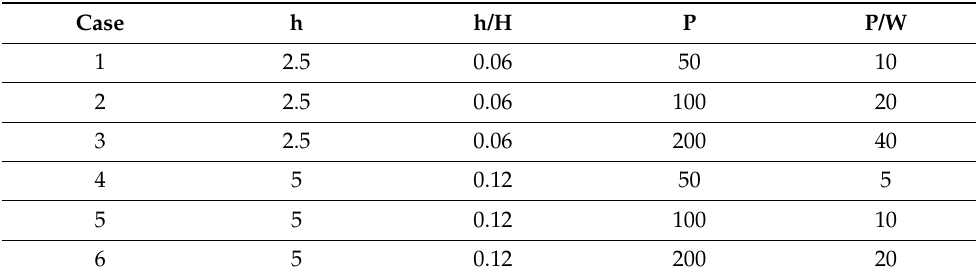
Figure 1. Schematic diagram of a channel with semicircle ribs [23]. Table 1. Dimensions of ribs for six cases.